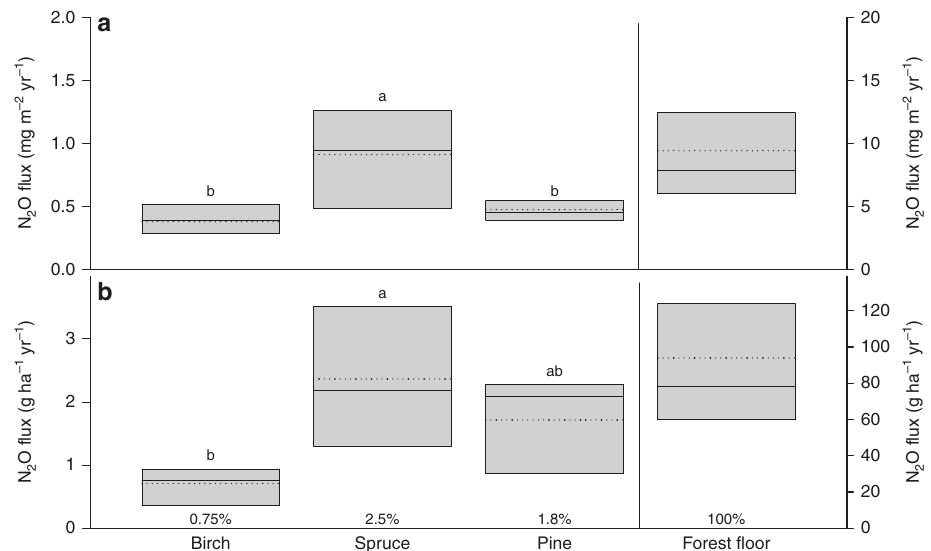
Fig. 6 Annual N 2 O fl uxes in tree stems and forest fl oor. The fl uxes are expressed per stem or soil surface area unit ( a ) and scaled up to unit ground area of boreal forest ( b ). The fl uxes are expressed as medians (solid line) and means (broken line) of measurements at both wet and moderately wet plots together, as the N 2 O fl uxes did not vary signi fi cantly between those plots at the annual scale. The dry plot was not included into this comparison of annual fl uxes because only pine trees were available at this plot. The stem fl uxes were measured from six trees per species ( n = 6), the forest fl oor fl uxes were determined at six positions ( n = 6). The box boundaries mark the 25th and 75th percentiles. Statistically signi fi cant differences in annual fl uxes among birch, spruce and pine at p < 0.05 are indicated by different letters above the bars. The contributions of stem fl uxes to forest fl oor N 2 O fl uxes (equal to 100%) are expressed as percentages of the forest fl oor fl